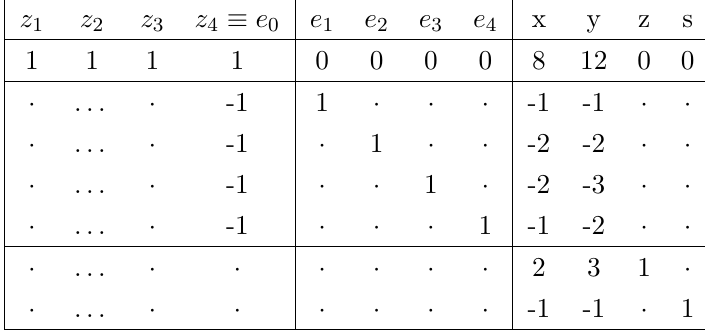
Table 6. Scaling relations of the elliptic (cid:12)bration over B 3 = P 3 Q